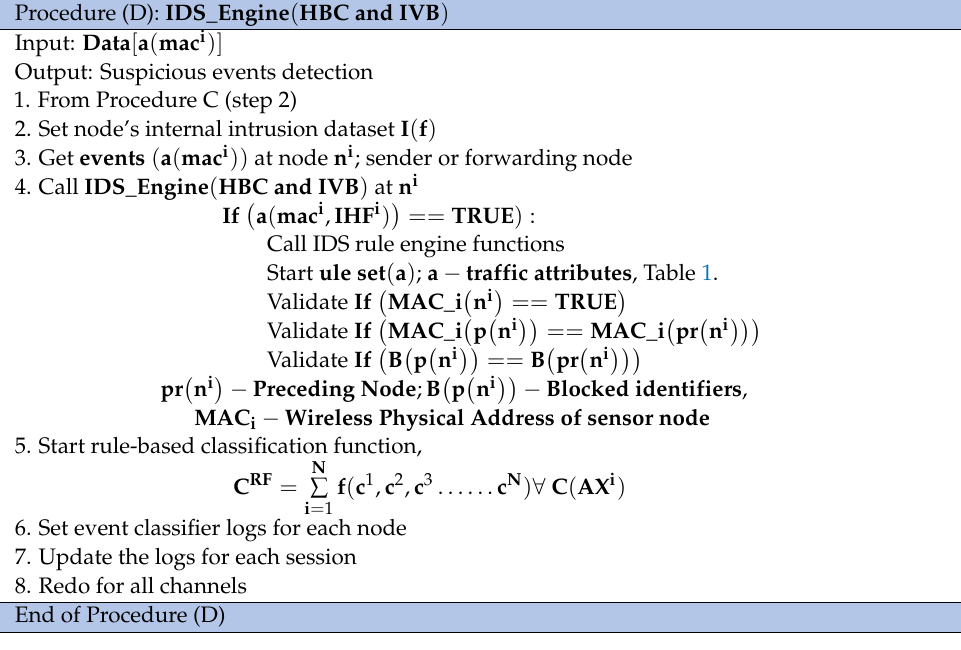
Algorithm 4. Procedure D.